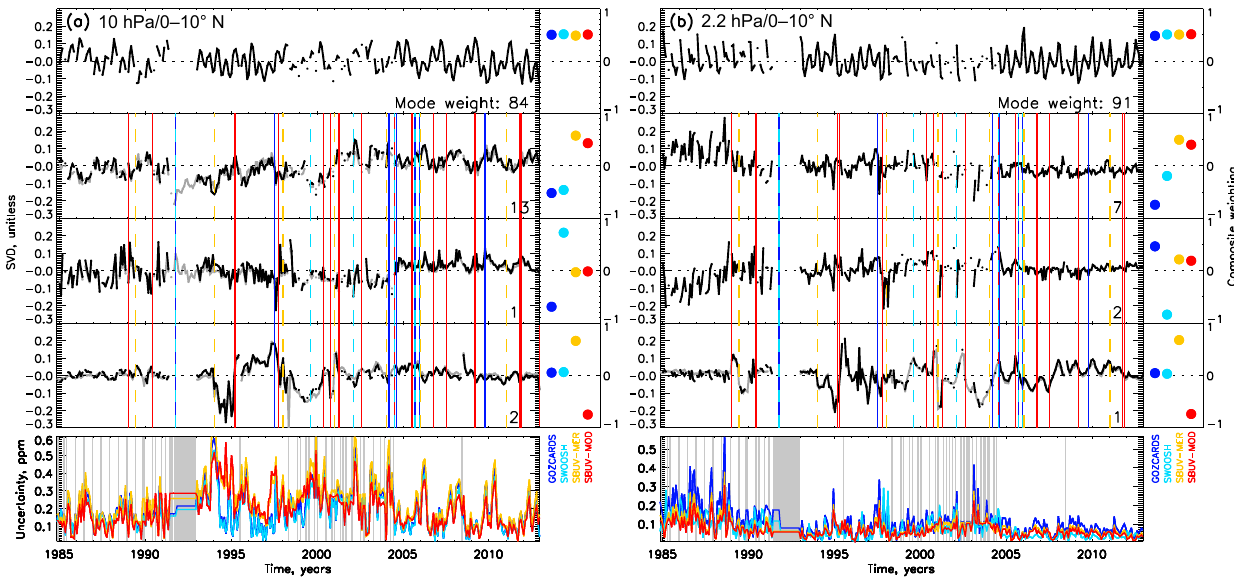
Figure 4. Visualization of the components of the SVD algorithm within the BASIC approach used to estimate the uncertainty on each ozone composite for two examples at (a) 10hPa and (b) 2.2hPa at 0–10 ◦ N. The left column of the first four rows show the determined singular value decomposition (SVD) unitless modes (black time series); the mode weighting (%) is given in the bottom right; the right column is the mode weighting for each composite. All colours represent information related to GOZCARDS (blue), SWOOSH (light blue), SBUV-MER (yellow), and SBUV-MOD (red). Vertical lines represent dates an instrument change in the composite occurred. The grey time series is the arbitrarily rescaled difference between SBUV-MER–GOZCARDS, SWOOSH–GOZCARDS, and SBUV-MER–SBUV-MOD in panel (a) in rows 2–4, and SBUV-MER–SBUV-MOD in panel (b) in row 4. The bottom panel (row 5) in panels (a) and (b) represents the uncertainty derived from the root sum of the squares of the modes (rows) 2–4, weighted by the mode and composite weight, in units of ppm. Grey vertical lines represent dates when data in any composite are missing and filled with the median uncertainty for the sub-period in which they lie (i.e. between the vertical lines in rows